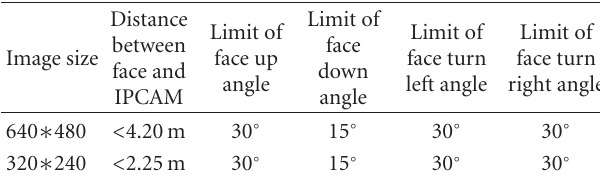
Table 2: The distance and image limit of face